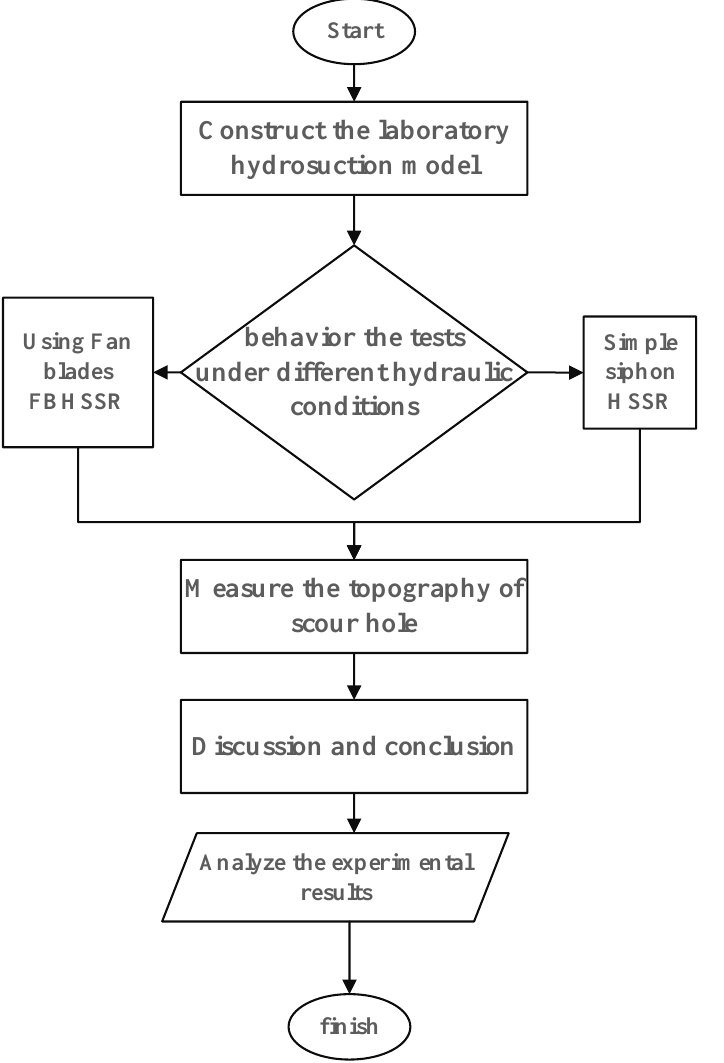
Figure 6. Flow chart for the processes of the experimental tests using both the HSSR and FBHSSR systems.